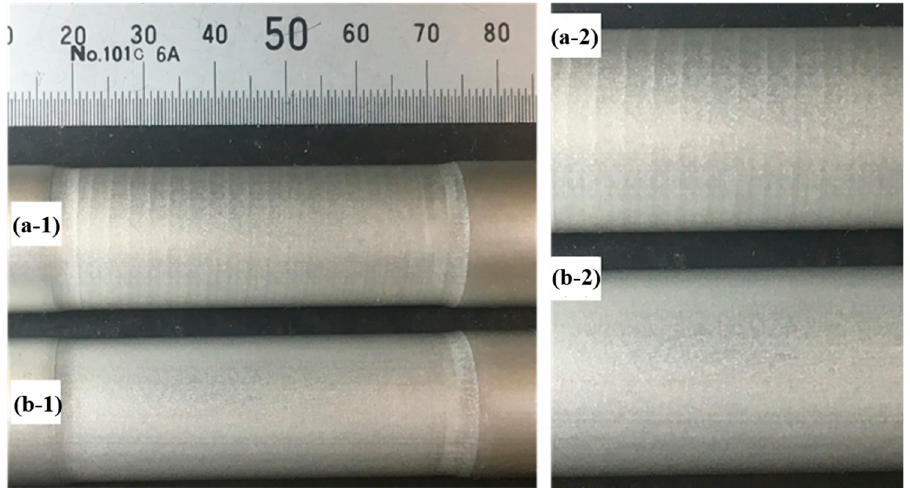
Figure 4. Appearance of the formed tubes ( a-1 ) spiral mark: the diameter reduction ratio κ D = 15%, n = 85 rpm, f = 3.0 mm/rev, ( b-1 ) smooth surface: κ D = 15 %, n = 85 rpm, f = 0.5 mm/rev. The photographs ( a-2 ) and ( b-2 ) are high magnification version of ( a-1 ) and ( b-1 ), respectively.